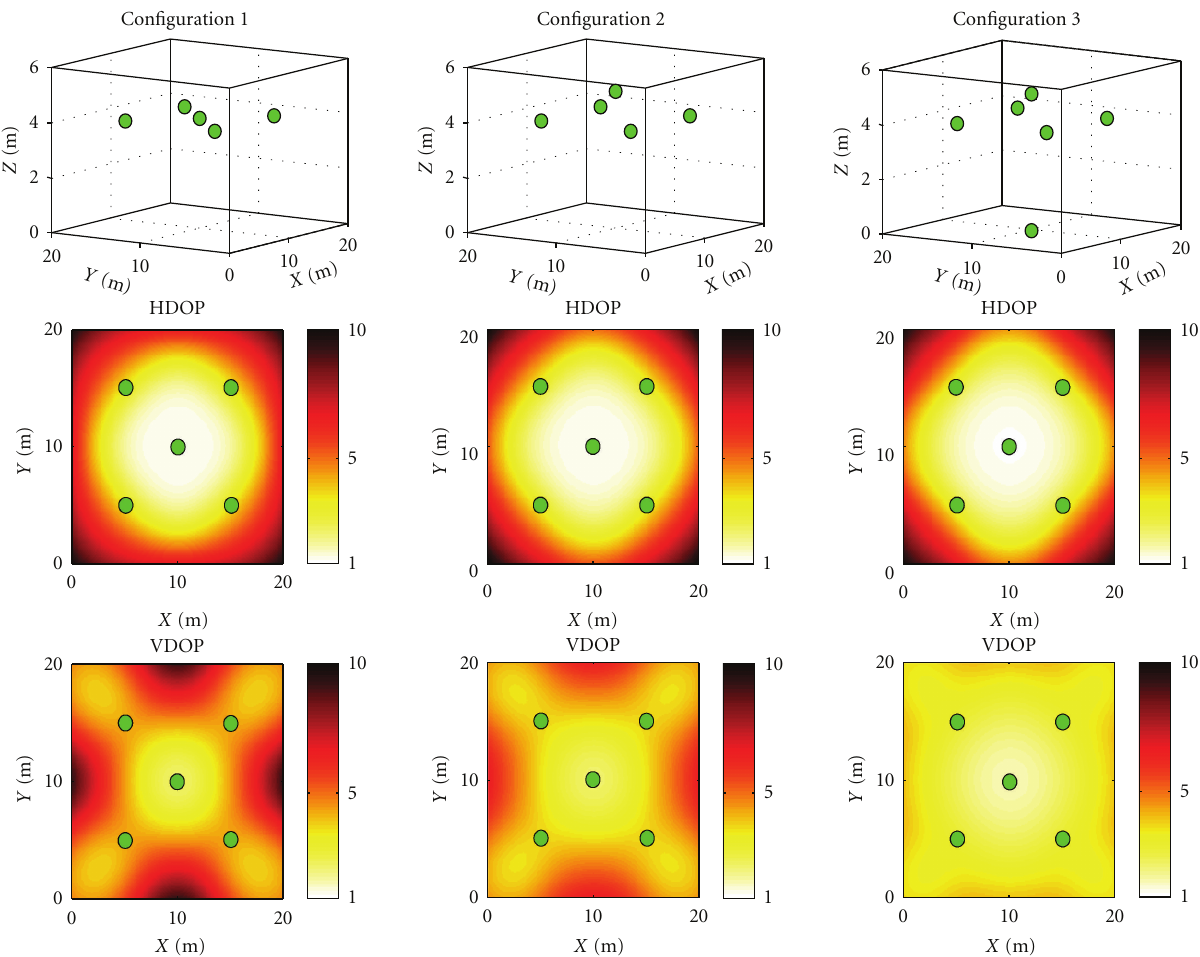
Figure 2: Spatial distribution of HDOP and VDOP values for three di ff erent access point configurations. The AP positions are marked with green dots.